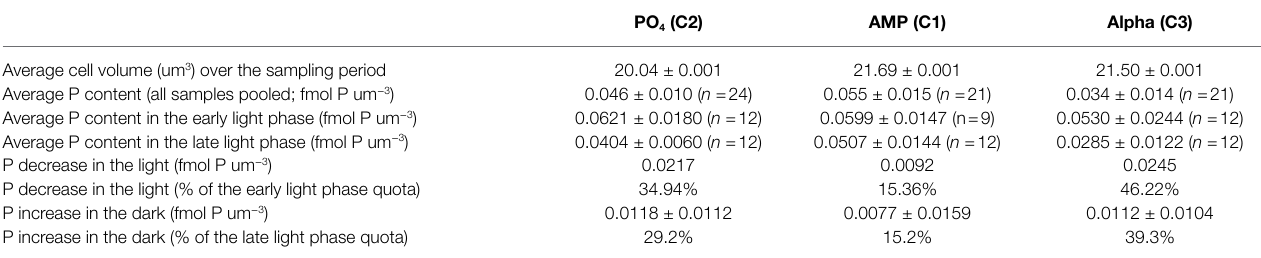
TABLE 5 | Particulate phosphorus normalized per cell volume, measured in exponentially growing cultures of Crocosphaera watsonii provided with either an inorganic (PO 4 ) or organic [mono phosphate adenosin (AMP) or DL- α -glycerophosphate (Alpha)] source of phosphorus for growth.